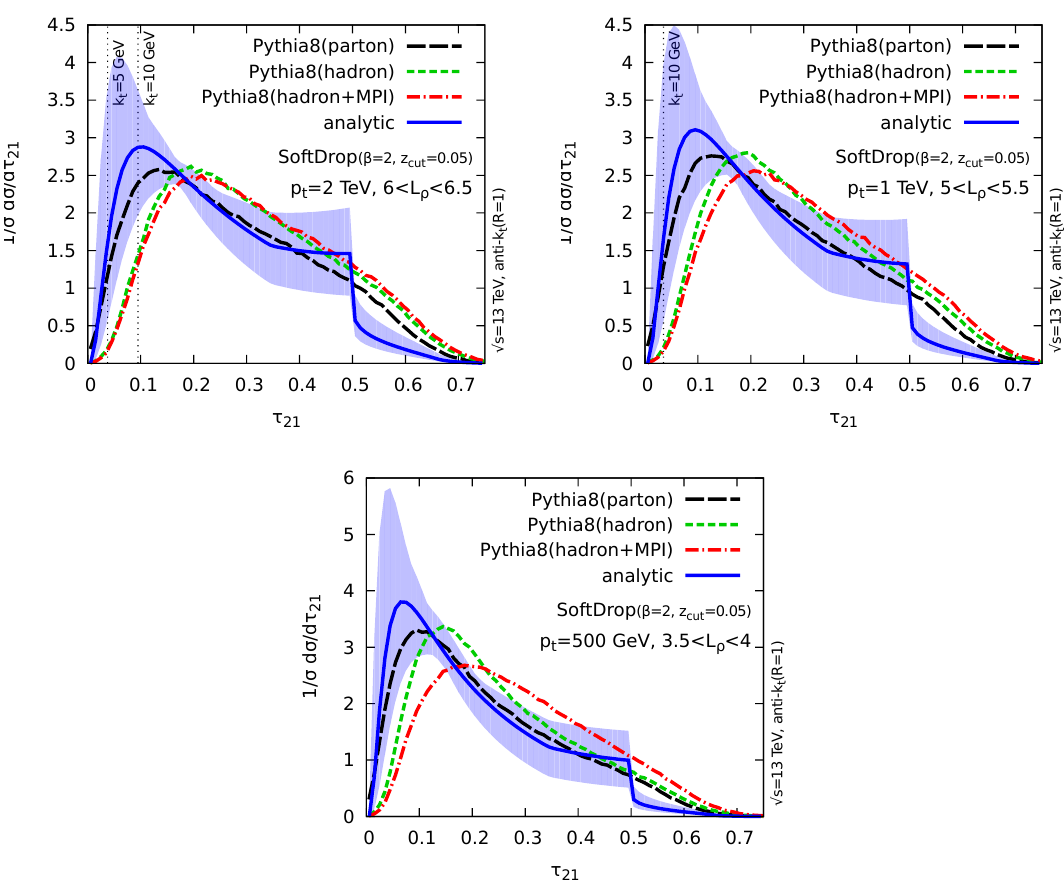
Figure 8 . Same as (cid:12)gure 6 now for di(cid:11)erent values of p t . Here we show results for the Pythia8 generator at di(cid:11)erent levels in order to gauge the importance of non-perturbative e(cid:11)ects. For each p t , the bin in L (cid:26) = log(1 =(cid:26) ) is adjusted to be roughly around the mass of the W boson (for